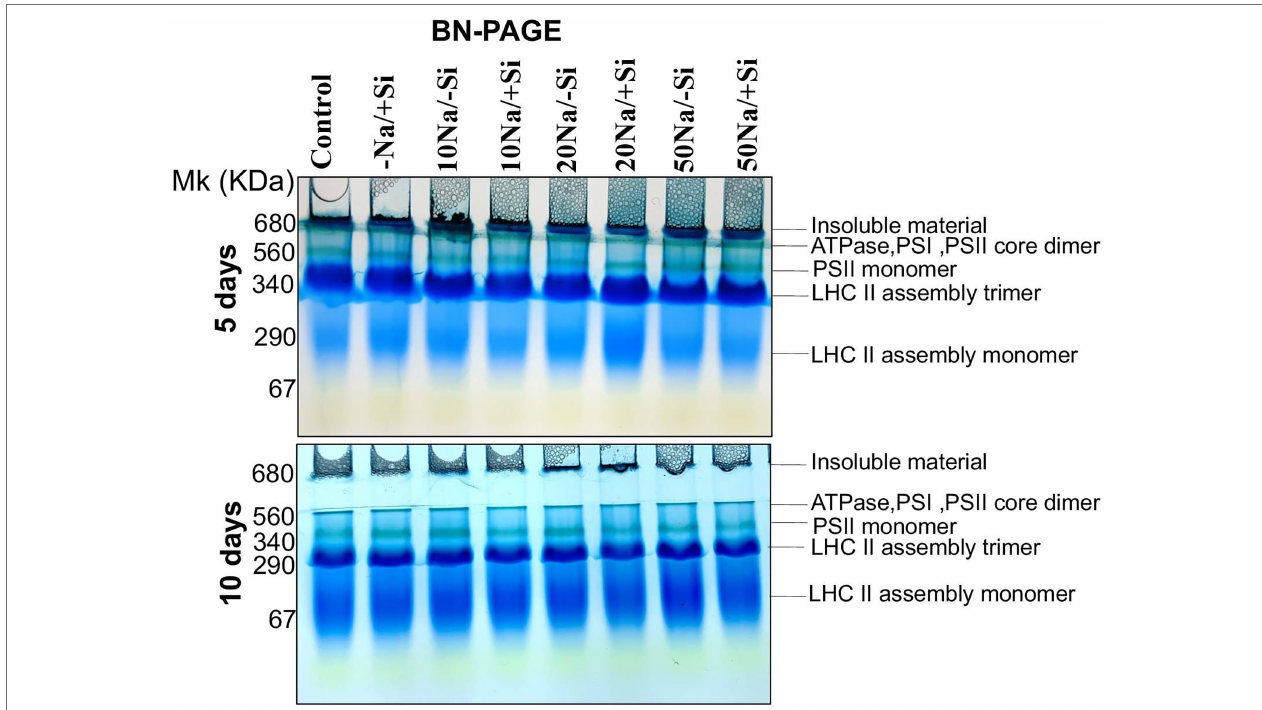
FIGURE 7 | First dimension BN-PAGE of mung bean ( Vigna radiata ) under 5 mM (Si 2 ) Si supply and salinity stress after eight treatments: (i) control (T1), (ii) − NaCl+Si (5 mM) (T2), (iii) 10 mM NaCl/ − Si (T3), (iv) 10 mM NaCl/+Si (5 mM) (T4), (v) 20 mM NaCl/ − Si (T5), (vi) 20 mM NaCl/+Si (5 mM) (T6), (vii) 50 mM NaCl/ − Si (T7), and (viii) 50 mM NaCl/+Si (5 mM) (T8) for a period of 5 and 10 days. For first dimension BN-PAGE fresh thylakoid membranes were solubilized in 1% BDM at chlorophyll concentration of 1 μ g μ l − 1 , and the protein sample was separated by 7–12.5% gradient